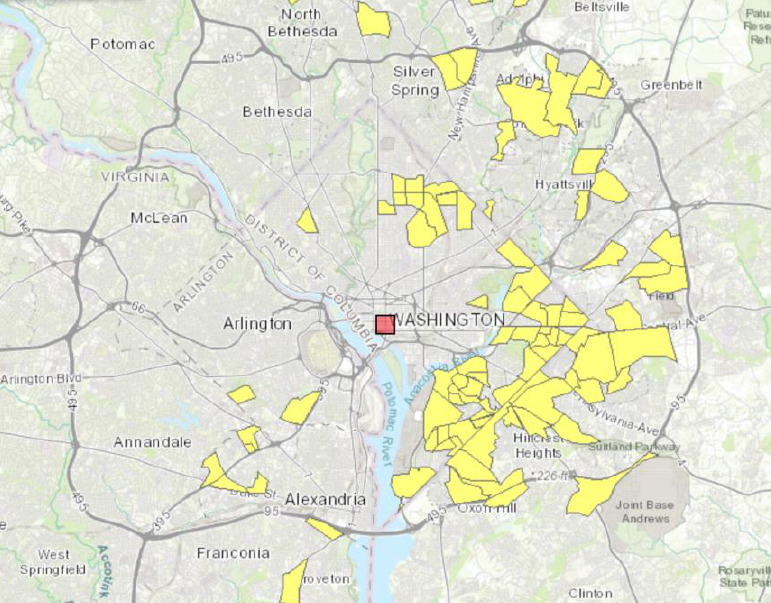
SCREENSHOT OF MAP ILLUSTRATING FOOD DESERTS IN THE WASHINGTON D.C. BELTWAY REGION. AREAS IN YELLOW DENOTE “LOW-INCOME CENSUS TRACT[S] WHERE MORE THAN 100 HOUSING UNITS DO NOT HAVE A VEHICLE AND ARE MORE THAN ½ MILE FROM THE NEAREST SUPERMARKET, OR A SIGNIFICANT NUMBER OR SHARE OF RESIDENTS ARE MORE THAN 20 MILES FROM THE NEAREST SUPERMARKET.” MAP CREATED BY TEHAMA LOPEZ BUNYASI USING THE INTERACTIVE MAPPING TOOL FOOD ACCESS RESEARCH ATLAS PROVIDED BY THE UNITED STATES DEPARTMENT OF AGRICULTURE’S ECONOMIC RESEARCH SERVICE. SOURCE: